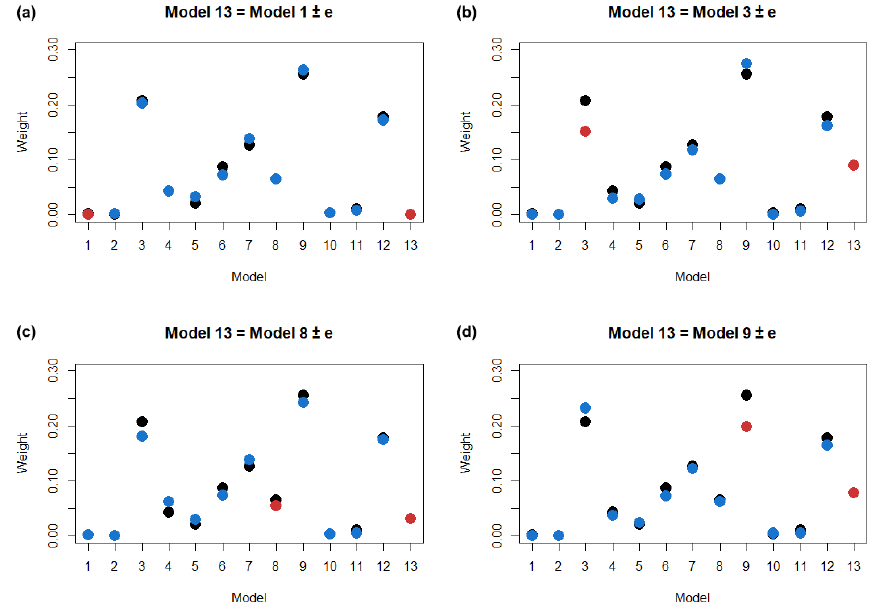
Figure 2. Change of MCE weights after adding a copy of Model 1, 3, 8 and 9 (clockwise from panel a ) to the NARCliM ensemble. The original MCE weights are in black. The weights of the modified ensemble are in blue, and the weights of the highly correlated models are in